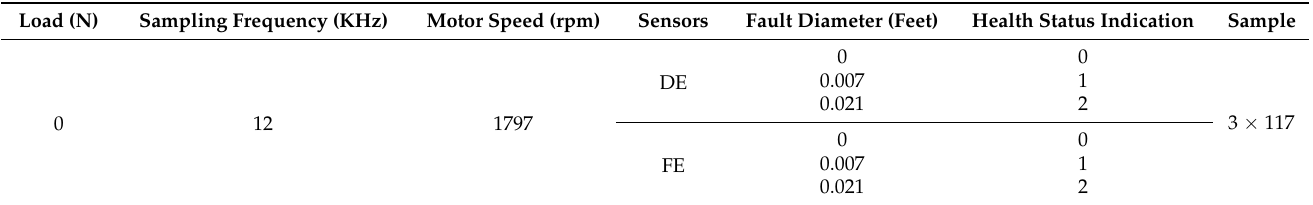
Table 1. Bearing public data collection working